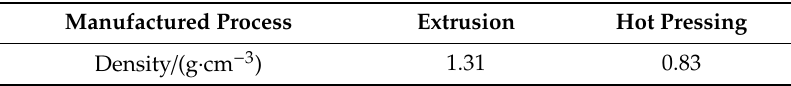
Table 2. Density of extruded and hot pressed straw / LLDPE composite.